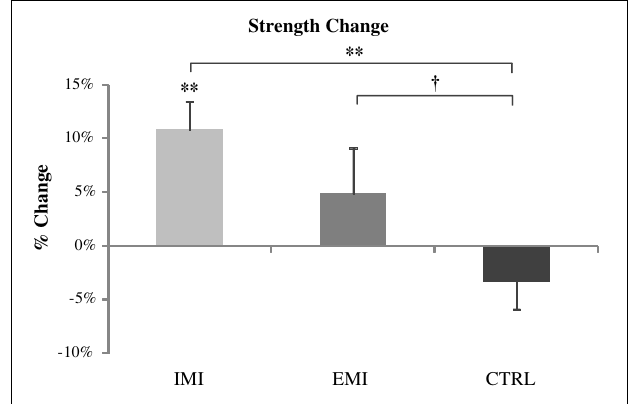
FIGURE 1 | Pre- to post-training percentage change in strength values for all three groups. Only the IMI group had a significant strength gain after training which was significantly greater than Control. EMI shows only marginal greater strength gain compared to Control. † P < 0 . 1, ∗ P < 0 . 05, ∗∗ P < 0 .